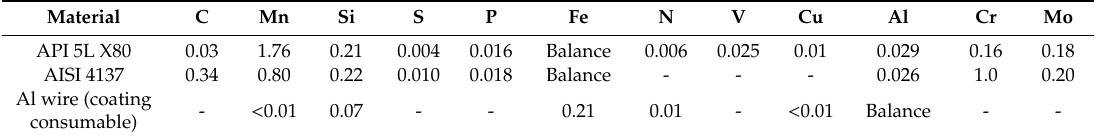
Table 1. Composition of the steels and coating consumable (wt